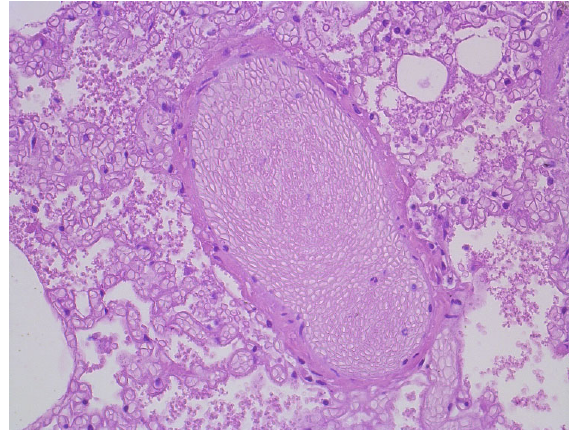
Fig. 12 A. Lungs. The artery is filled with red blood cells.